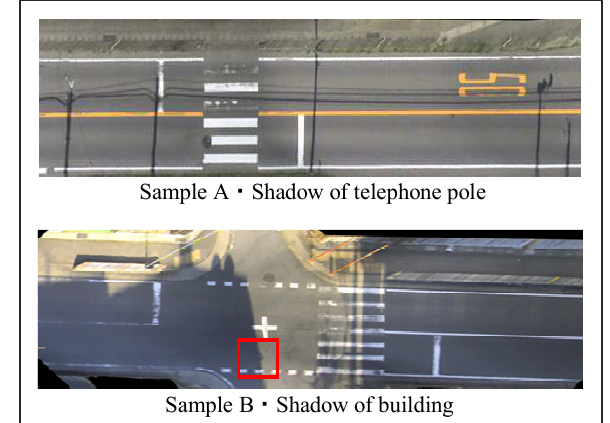
Sample B ・ Shadow of building Figure 1. Road surface orthophotos (Includes shadows)